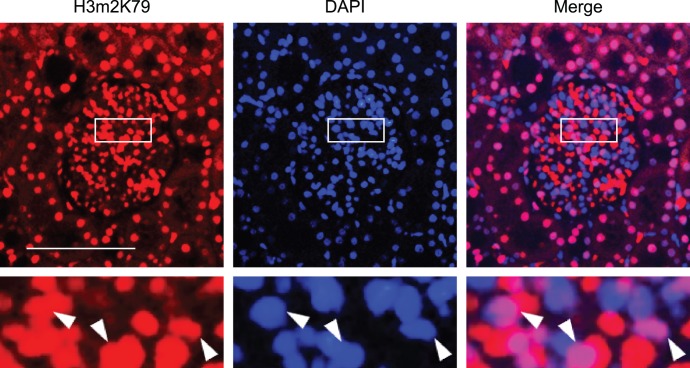
Dot1a as indicated by H3m2K79 is expressed in glomerular cells.Representative immunofluorescence images showing di-methyl histone H3 K79 (H3m2K79) staining in a normal rat glomerulus. Boxed areas were amplified and shown at the bottom. H3m2K79, an indicator of Dot1a methyltransferase activity, was stained in red. Nuclei were visualized by DAPI staining. The merged images demonstrate the presence of H3m2K79 in the nuclei of some (arrowhead), but not all of cells in the glomerulus. Scale bar: 100 µm and 25 µm for the amplified boxed areas.